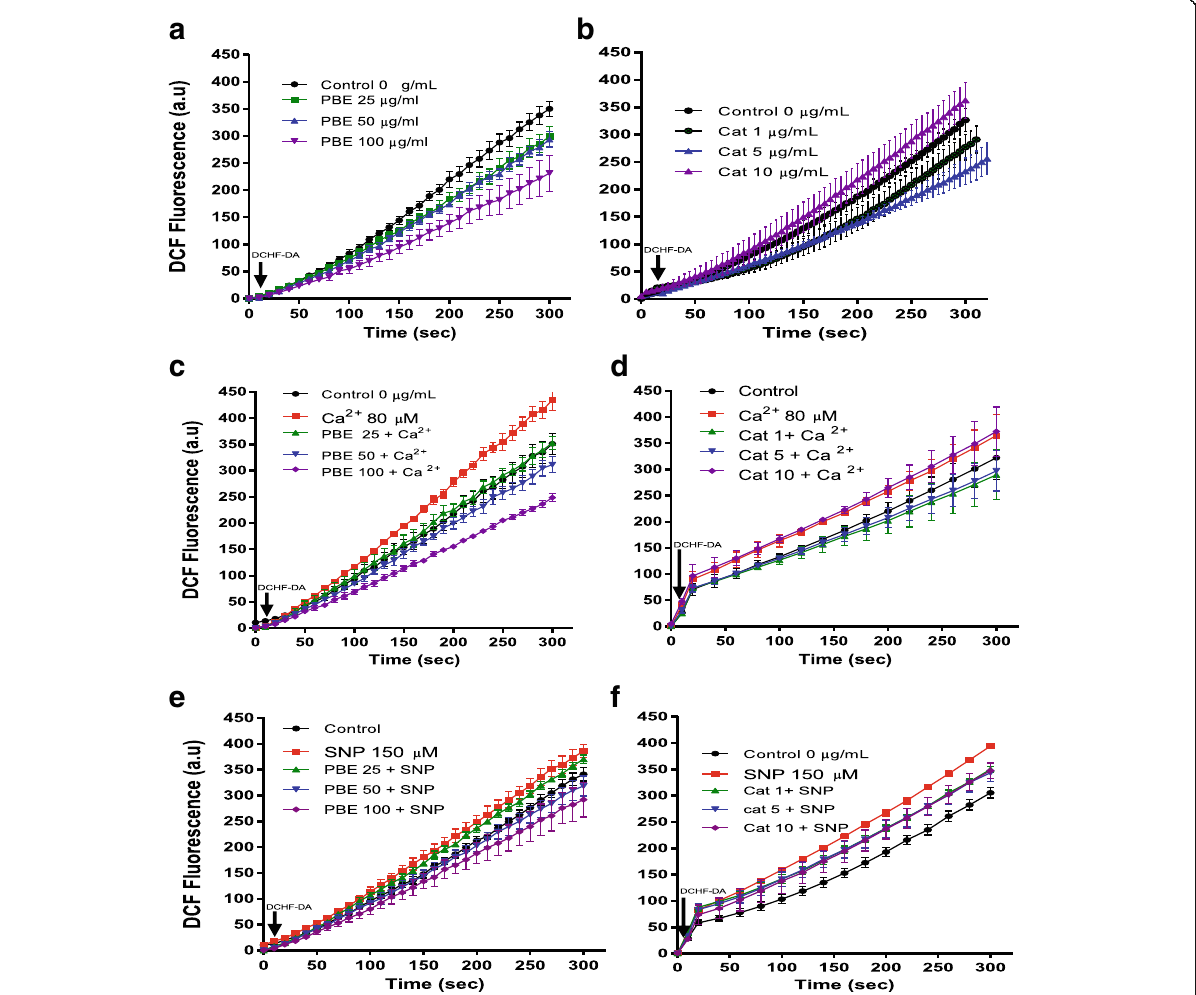
Fig. 5 Respective effect of Parkia biglobosa leaf extract (PBE) and catechin on basal ROS production ( a and b ), Ca 2+ − induced ( c and d ) and SNP-induced ( e and f ) aggravation of ROS generation in isolated rats ’ liver mitochondria. Data is presented as mean ± SEM of three assays performed in triplicates using independent mitochondrial preparations. a PBE 25-, 50-, 100 μ g/ml ( P < 0.001 vs Control), ( b ) Cat 1-, 5-, 10 μ g/ml non-significant vs control ( P > 0.05), ( c ) Ca 2+ 80 μ M , PBE 100 μ g/ml ( P < 0.001 vs control), ( d ) Ca 2+ 80 μ M , Cat 10 μ g/ml ( P < 0.01 vs